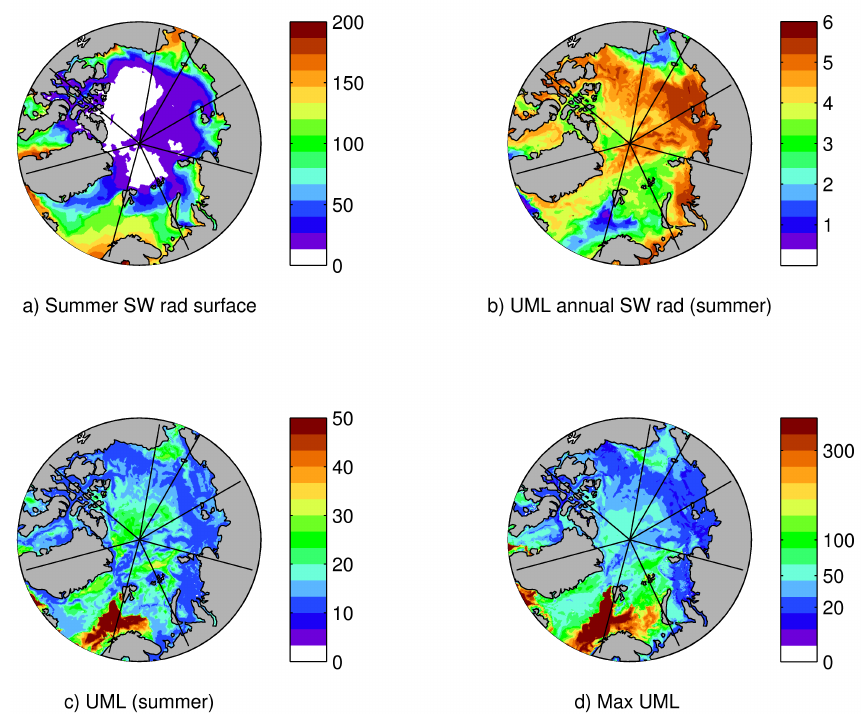
Fig. 4. Model results for year 1997: (a) Summer (May–September) average short-wave radiation at the ocean surface Wm − 2 ); (b) summer (May–September) average UML depth (m); (c) maximum modelled depth of UML during the year (note non-linear colour scale) on the basis of 5 day average values